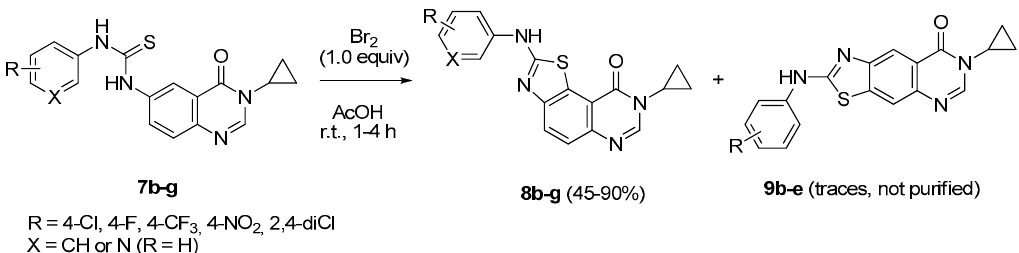
Scheme 6. Synthesis of 8-cyclopropyl-2-(arylamino)thiazolo[5,4- f ]quinazolin-9(8 H )-ones 8b–f and